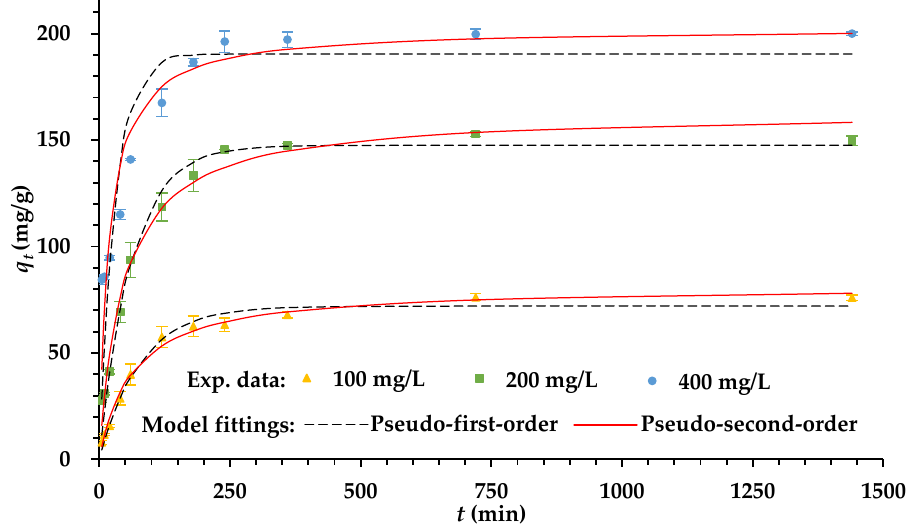
Figure 4. Adsorption kinetics of Cu(II) on to chestnut shells at different initial concentrations (acrylic acid/chestnut shell pigment) (Temperature = 300 K, pH = 6, adsorbent dosage = 1 g/L).